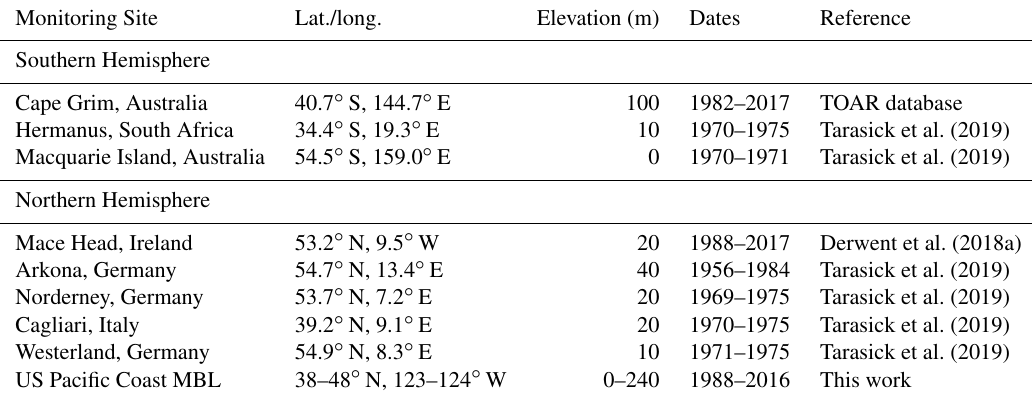
Table 1. Ozone data sets and analyses utilized in this